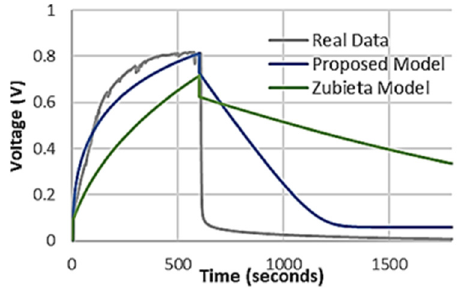
Figure 4. Real charge test Bio-gel EDLC data compared to the simulated Zubieta and Proposed equivalent circuit Model 1.